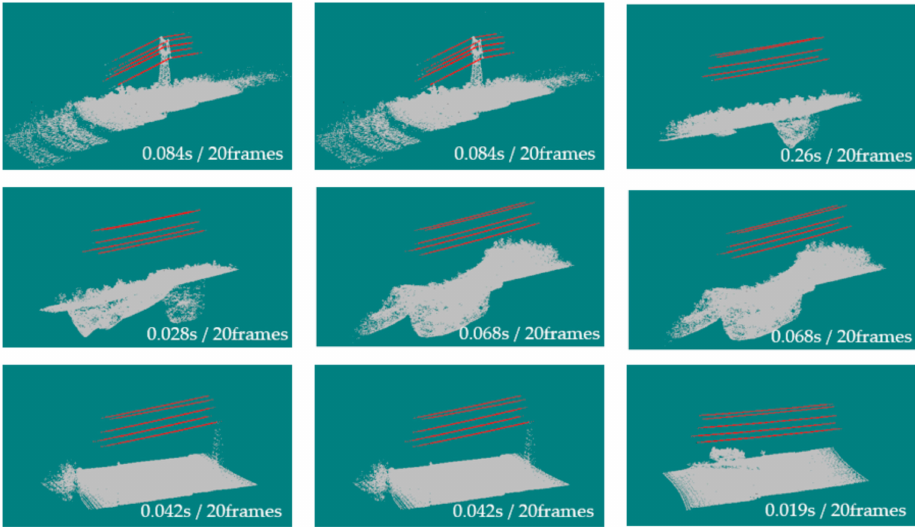
Figure 13. The results of sequential blocks (each block includes 10 s, 200 frames data). The average time consumption of processing 20 frames is labelled in the bottom right